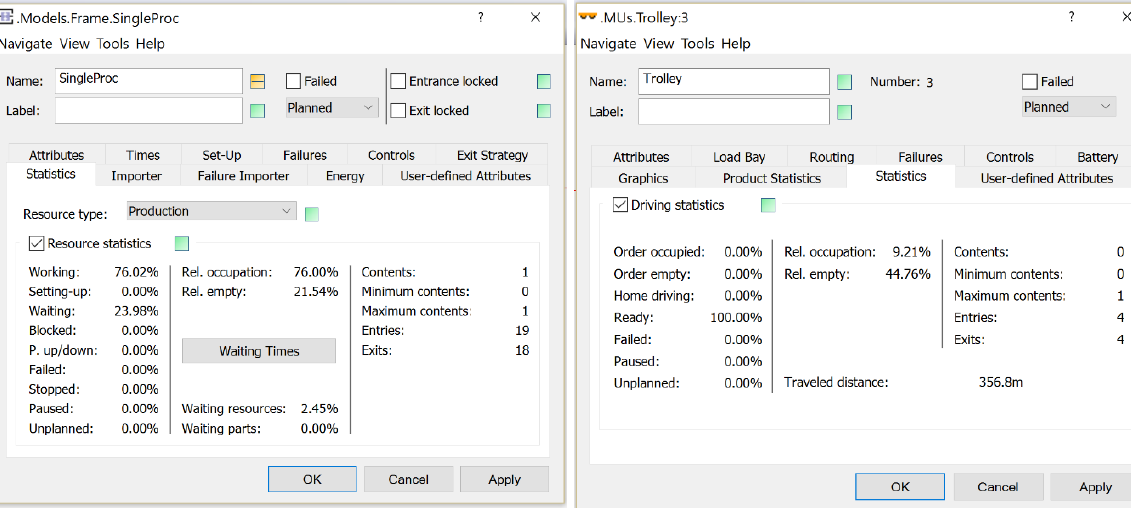
ous supplementary methods, e.g. using the additional pro- gramming (Fig.